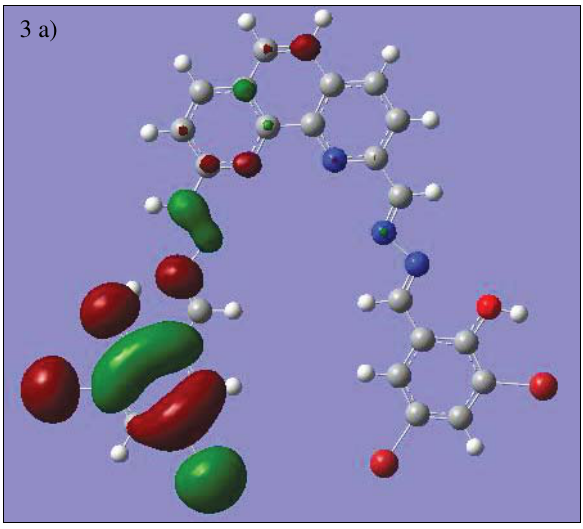
Fig. 9. Molecular orbital level of compound 3 , a) HOMO; b)